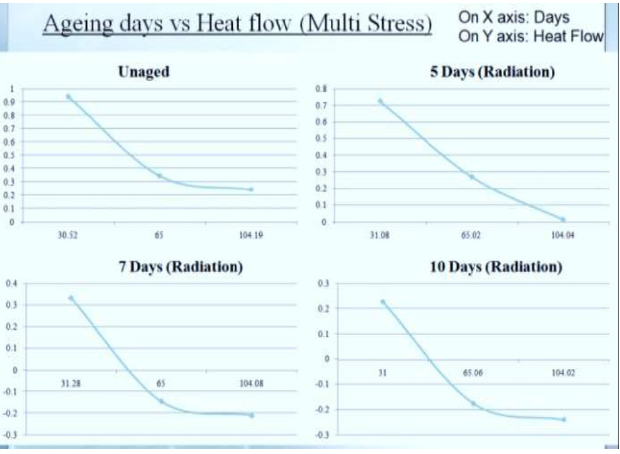
FIG. 19. EFFECT OF AGEING DAYS WITH MULTI STRESS